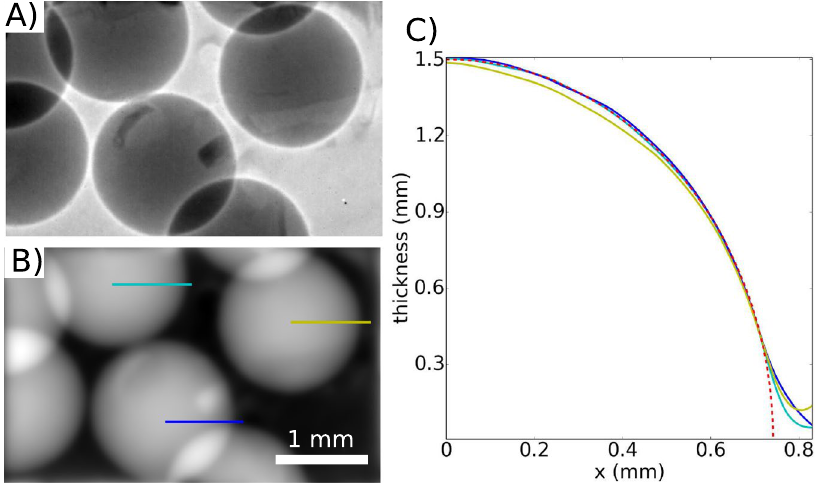
Figure 3. PMMA spheres ( A ) edge enhanced image, ( B ) thickness reconstruction and ( C ) intensity profile along the lines highlighted in ( B ) compared with the theoretical thickness of perfect PMMA spheres (red dashed line). Overlying imperfections are largely due to the kapton tape holding the spheres in